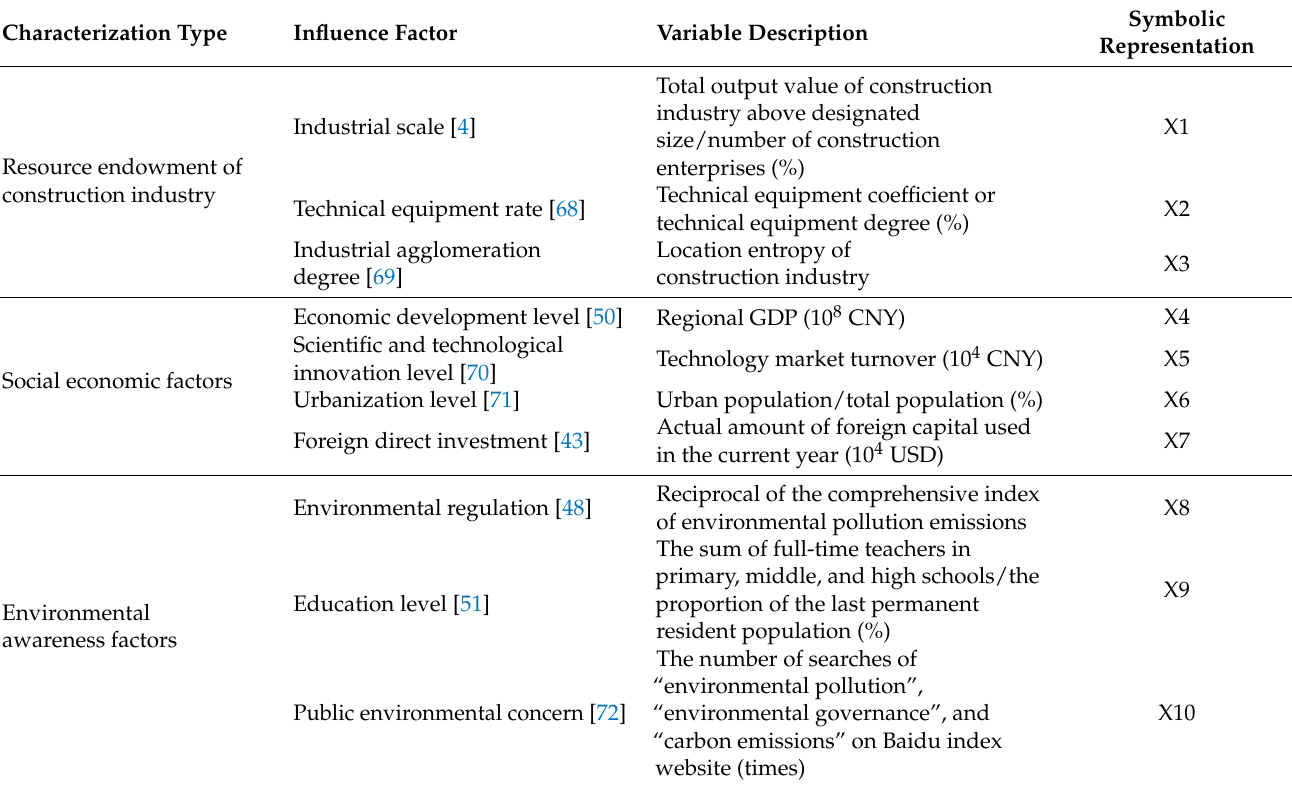
Table 3. Influencing factors and classification of green technology innovation efficiency in the construction